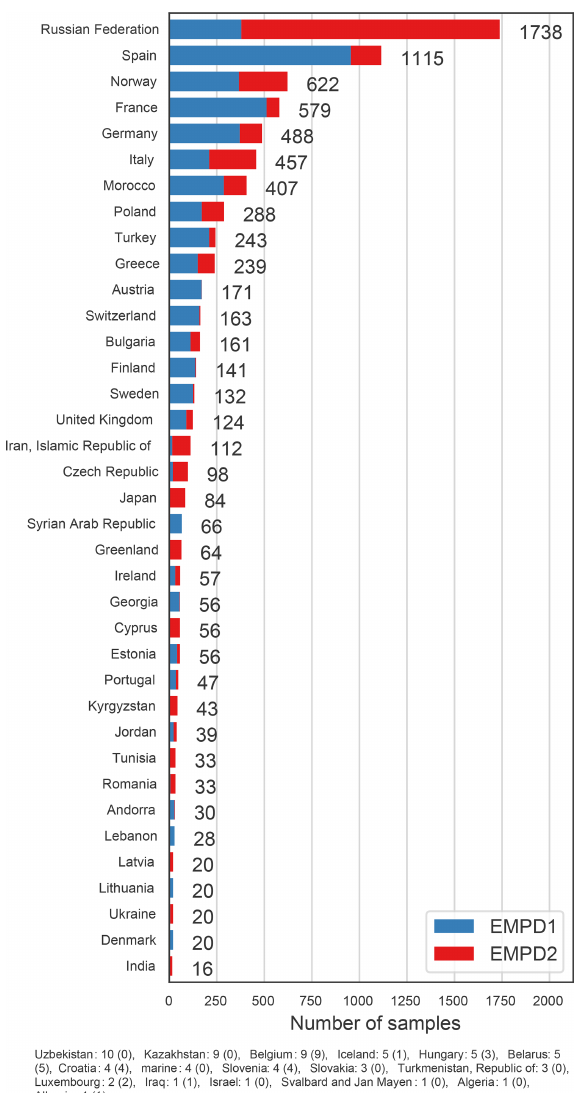
Figure 2. A comparison of the number of samples in EMPD ver- sions 1 and 2, by country. Countries with only small numbers of samples are listed at the bottom; values in brackets indicate new samples in